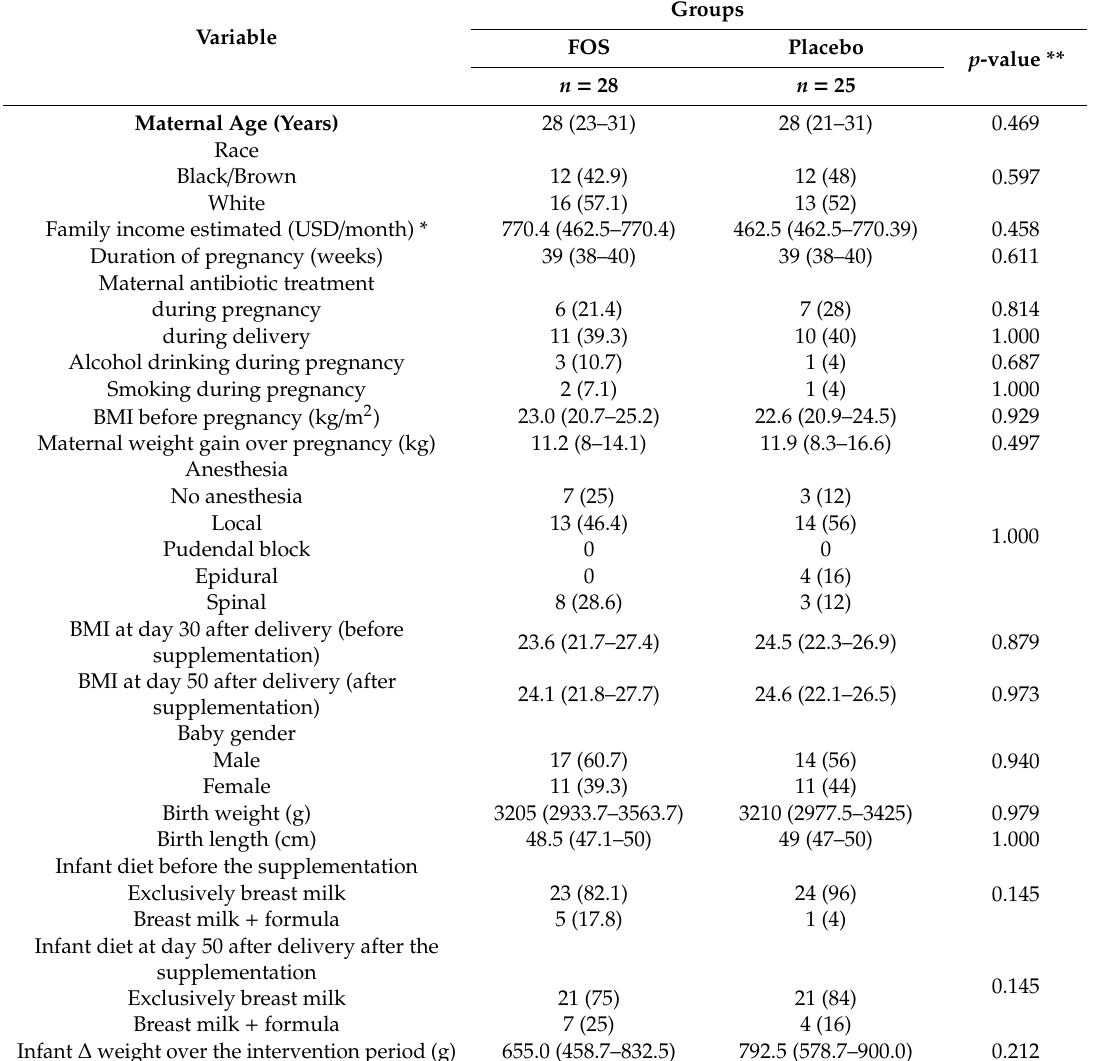
Table 1. Clinical and demographic characteristics of the volunteers who concluded the clinical trial, according to the groups ( n =